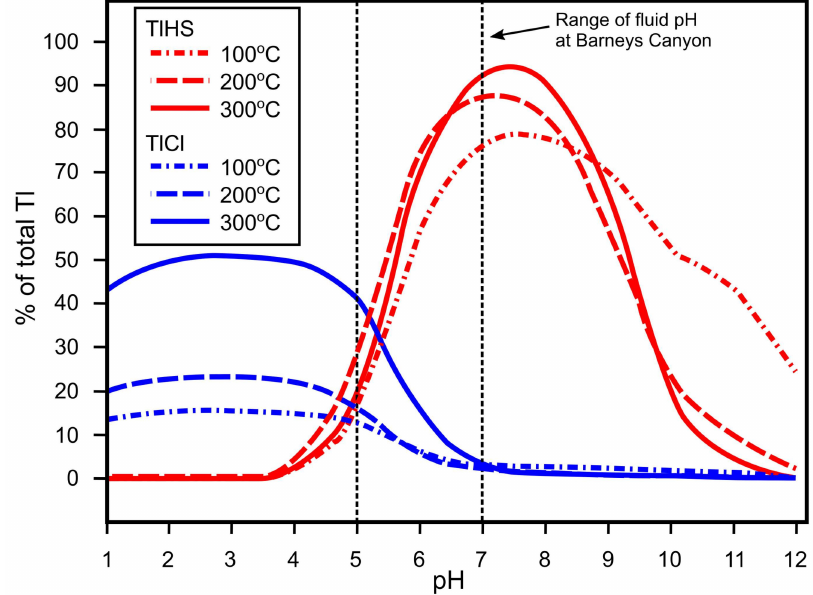
Figure 9. Modelled % of total Tl transported by Cl − and HS − anions in hydrothermal fluids plotted against fluid pH in reducing conditions at temperatures between 100–300 ◦ C; modified after